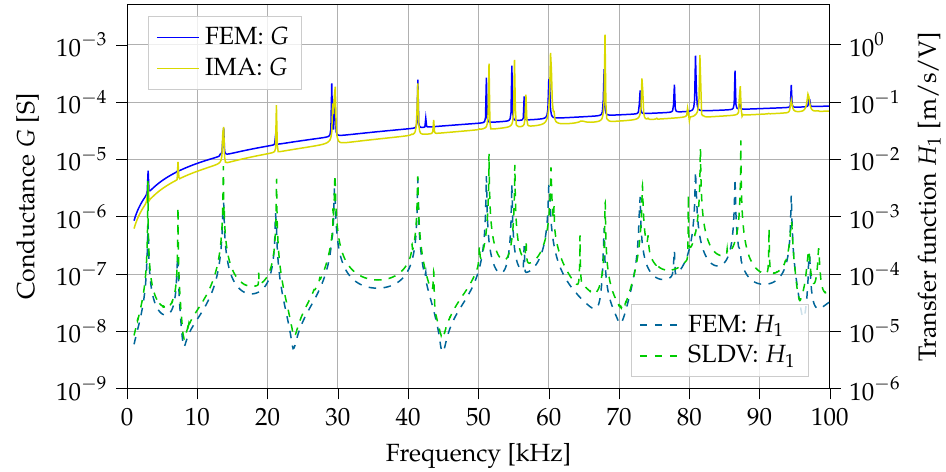
Figure 4. Frequency spectra of the pristine necked lug calculated with the FEM and measured with the IMA as well as with the